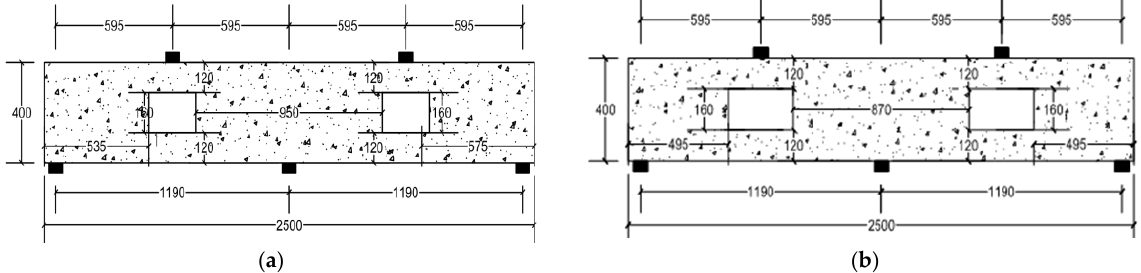
Figure 12. Typical layouts of the RCCDBs with different ratios of the opening dimensions (all dimensions are in mm): ( a ) ratio: 1.5; ( b ) ratio: 2.0.